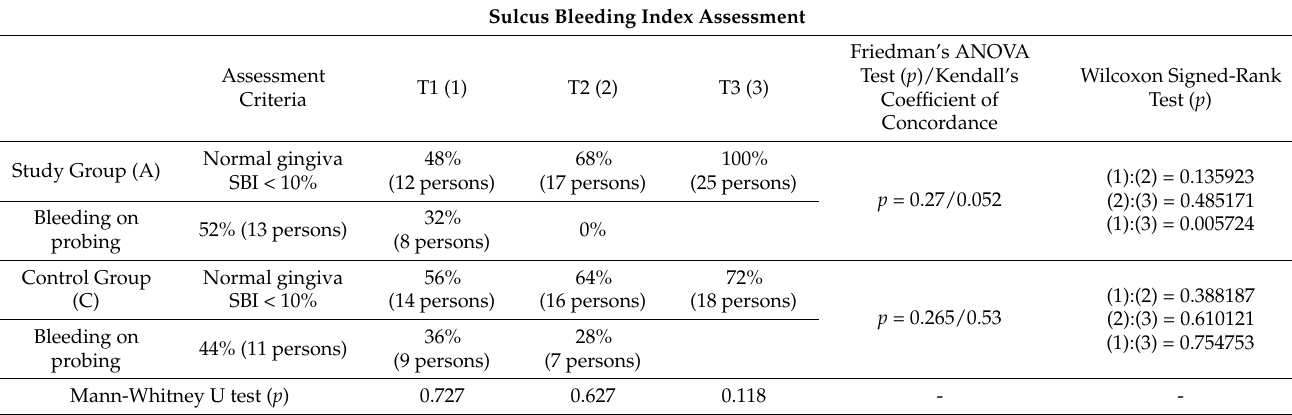
Table 4. Modified sulcus bleeding index (mSBI) ranges — assessment for study and control groups.